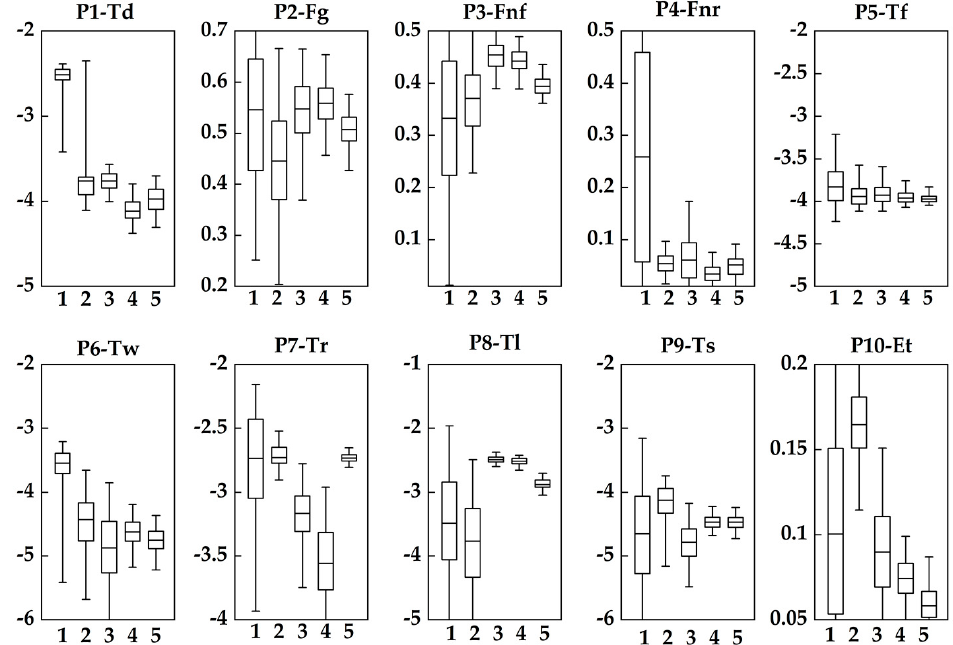
Figure 2. Posterior distributions of parameters (listed in Table 2) estimated for the DALEC model using a variety of different data constraints (Runs 1–5, x -axis, see Table 1). All y -axis represent priori range. Whiskers indicate 95% confidence interval; box indicate interquartile range). Table 2. DALEC model parameters.